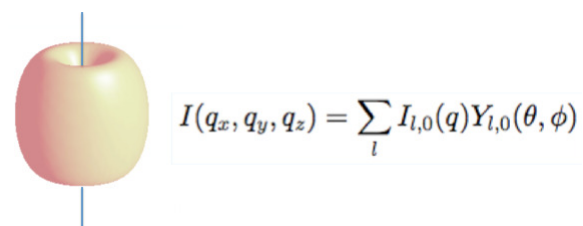
Figure 4. Expansion in spherical harmonics with respect to the z